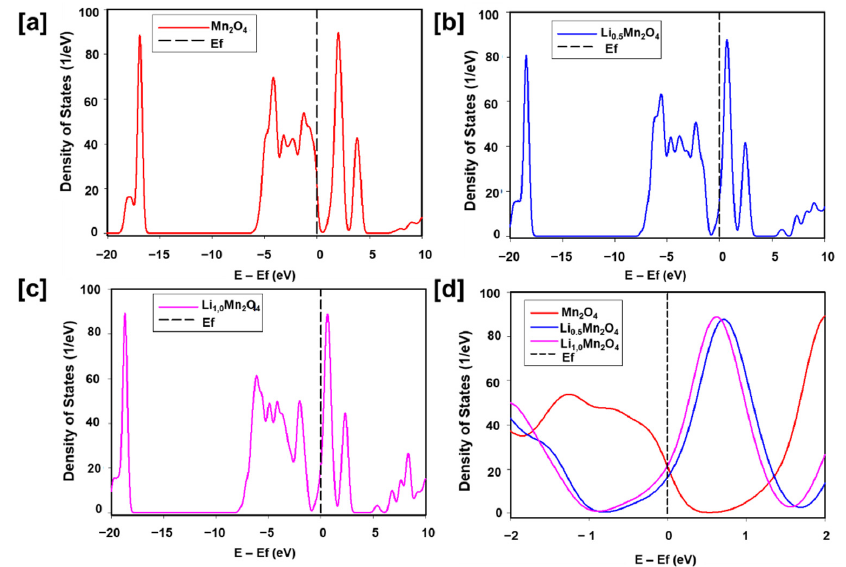
Figure 7. Changes in DoS of Li-Mn-O spinel during lithium intercalation for ( a ) Mn 2 O 4 , ( b ) Li 0.5 Mn 2 O 4 and ( c ) Li 1.0 Mn 2 O 4 with CASTEP (Cambridge Serial Total Energy Package). ( d ) Comparison of DoS of Mn 2 O 4 , Li 0.5 Mn 2 O 4 and Li 1.0 Mn 2 O 4 at the fermi energy.